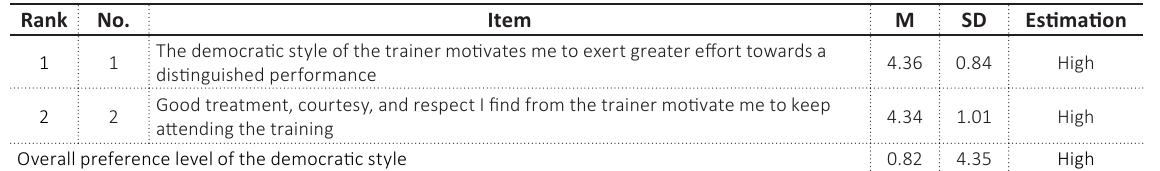
Table 5. Means and standard deviations of respondents’ responses to items